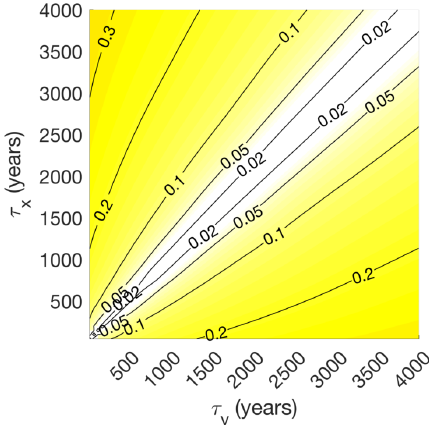
Figure 4. Error-to-signal variance fractions f (Eq. 5) for estimates of time-mean values computed from the NGRIP record of Pleis- tocene oxygen isotopes contoured as a function of target averaging interval τ x and observation averaging interval τ y . A value of 0.1 means that TR error amplitudes are 10% of the “signal,” which is defined as the typical difference between two time averages over durations τ x separated by 21000